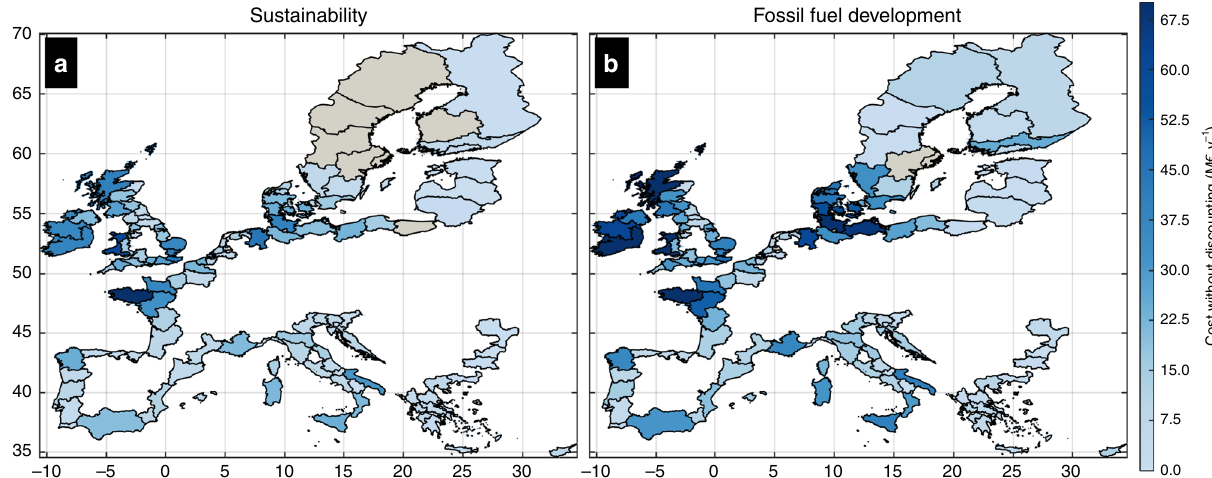
Fig. 3 Cost of coastal protection at regional level. Expected annual undiscounted costs of adaptation per NUTS2 region (expressed in million € per year) for Sustainability with RCP4.5 ( a ) and fossil fuel based development with RCP8.5 ( b ). Colours express the expected annual value averaged over the entire century (2020 –